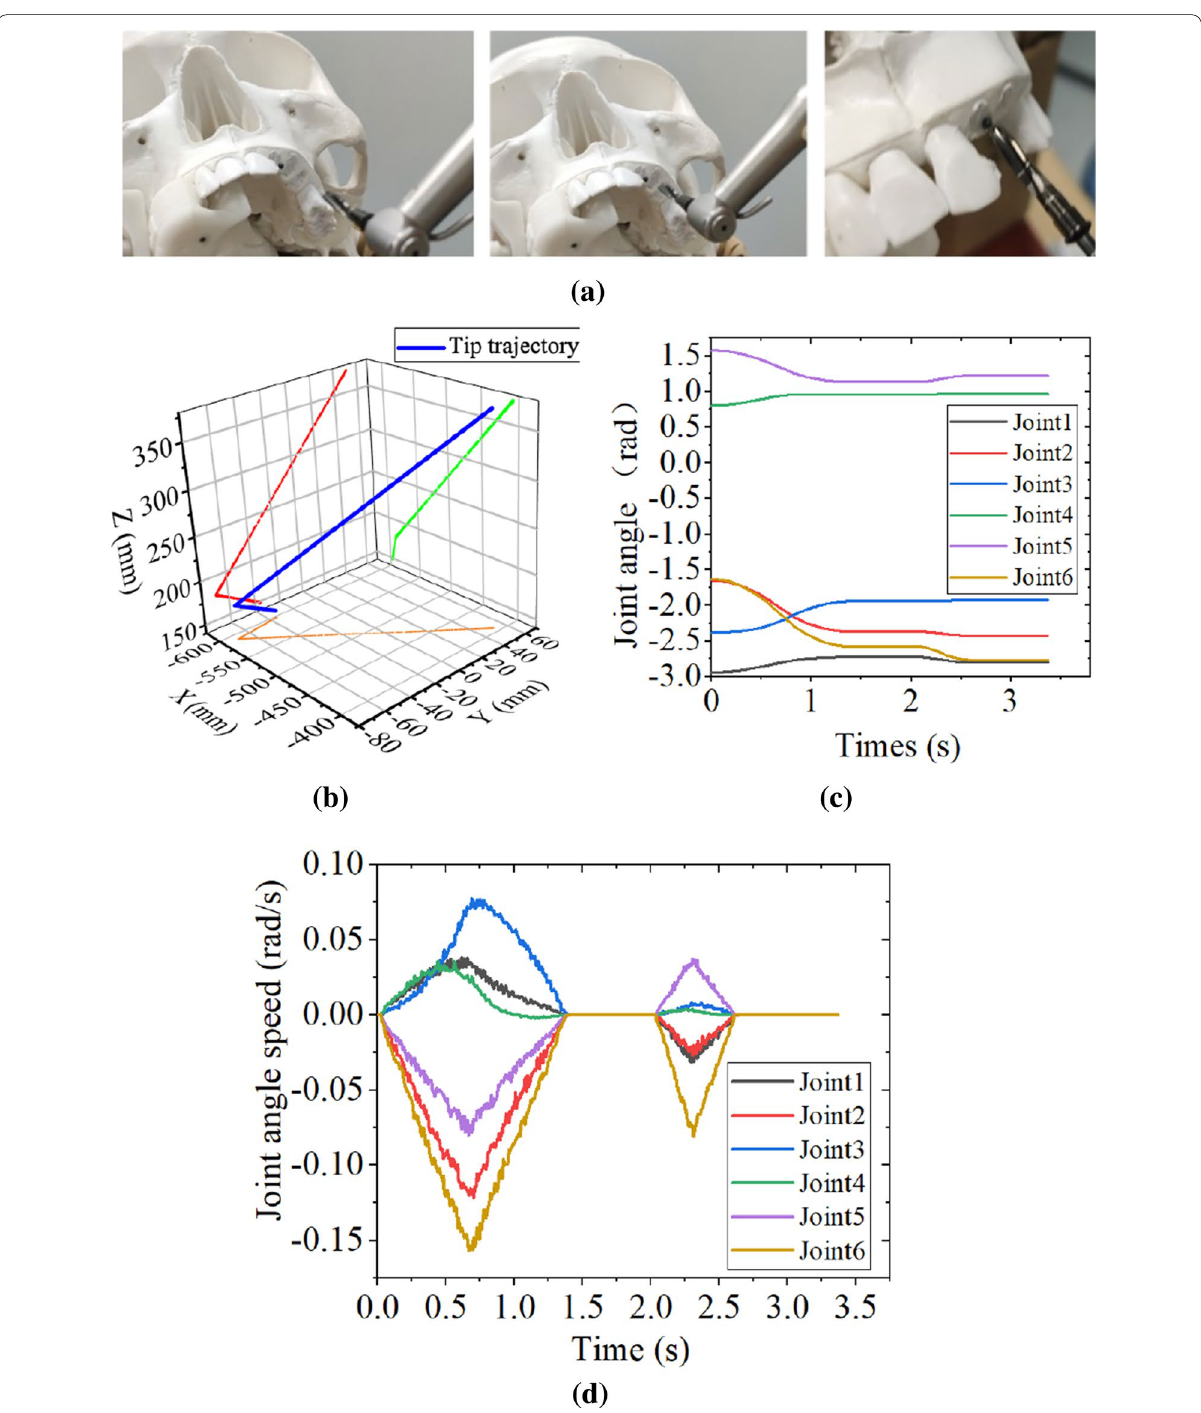
Figure 12 The results of auxiliary positioning method: a After the needle tip reaches the target point, manually push the robotic arm to move along the fixed path in the UR5e force mode, b The trajectory of the needle tip, c Real-time angle of each joint of the robot, d Real-time angular velocity of each joint of the robot, the time period when the speed is zero represents the program interval